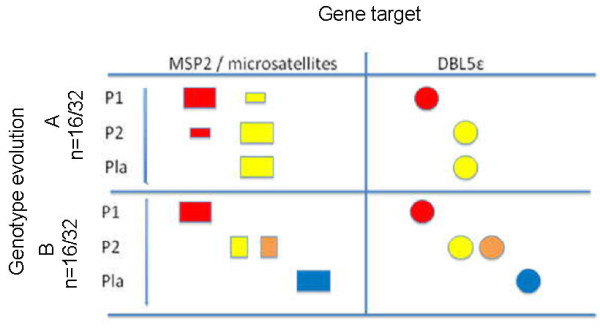
Dynamics of parasite populations during pregnancy. Two kinds of patterns (A and B) are described. P1, P2 represent positive parasitaemia from peripheral blood collected during the pregnancy, Pla represents placental blood collected at delivery. msp2/microsatellites genotypes are represented by squares. For one pattern, the various colors of the square represent a distinct msp2/microsatellite genotype. The different DBL5ε+Id5 sequence types are represented by different colored circles.